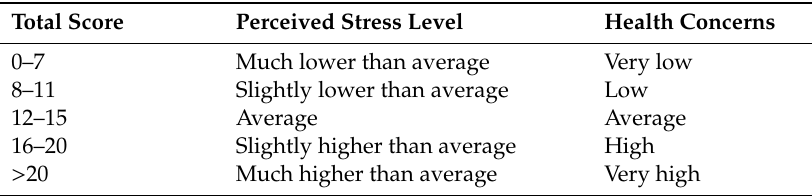
Table 4. Perceived stress and health concerns according to score. Total Score Perceived Stress Level Health Concerns 0–7 Much lower than average Very low 8–11 Slightly lower than average Low 12–15 Average Average 16–20 Slightly higher than average High > 20 Much higher than average Very high Source: Kelly and Percival [22].